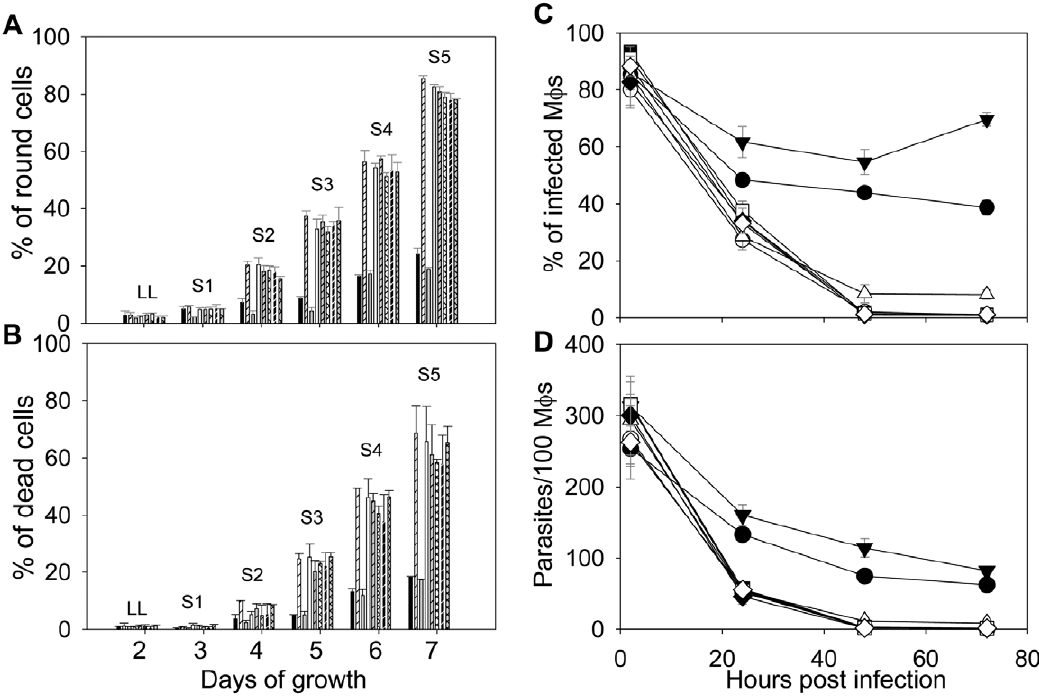
Figure 3. Mutated forms of ISCL failed to complement iscl 2 parasites. ( A–B ) Promastigotes were cultured in M199 medium and percentages of round cells (defined as those promastigotes whose long axis is shorter than twice the length of the short axis) ( A ) and dead cells ( B ) were recorded in late log (LL) and stationary phase promastigotes (S1–S5) as described [21]. Each group of bars represents cells in the following order (from left to N right): WT, iscl 2 , iscl 2 / + ISCL, iscl 2 / + pXG, iscl 2 / + ISCL D116G, iscl 2 / + ISCL D200G, iscl 2 / + ISCL D383G, and iscl 2 / + ISCL D . ( C–D ) Stationary phase : WT, # : iscl 2 , . : iscl 2 / + ISCL, & : iscl 2 / + ISCL D116G, % : iscl 2 / + ISCL D200G, X : iscl 2 / + ISCL D383G, e : iscl 2 / + ISCL D ) were used to promastigotes ( infect bone-marrow derived macrophages (M w s) from BALB/c mice at a ratio of 15 parasite per M w . Percentages of infected M w s ( C ) and parasites per 100 M w s ( D ) were determined at 2, 24, 48, and 72 hours post infection as described. As a control, WT parasites were also used to infect M w s that were activated with 100 ng/ml of LPS and 100 ng/ml of IFN- c ( n : WT + activated M w s). Experiments were repeated 3 times and error bars represent standard deviations.